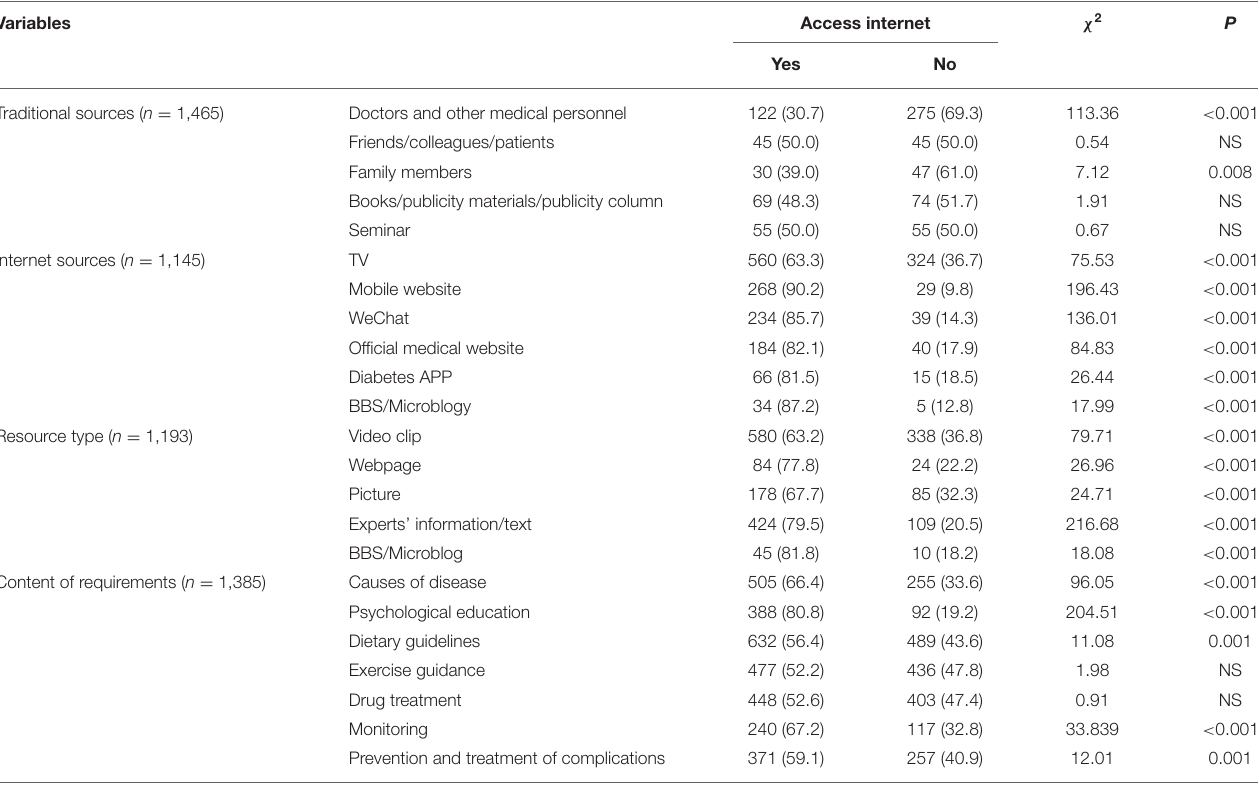
TABLE 3 | Respondents’ expectations of web-related information [ n ,